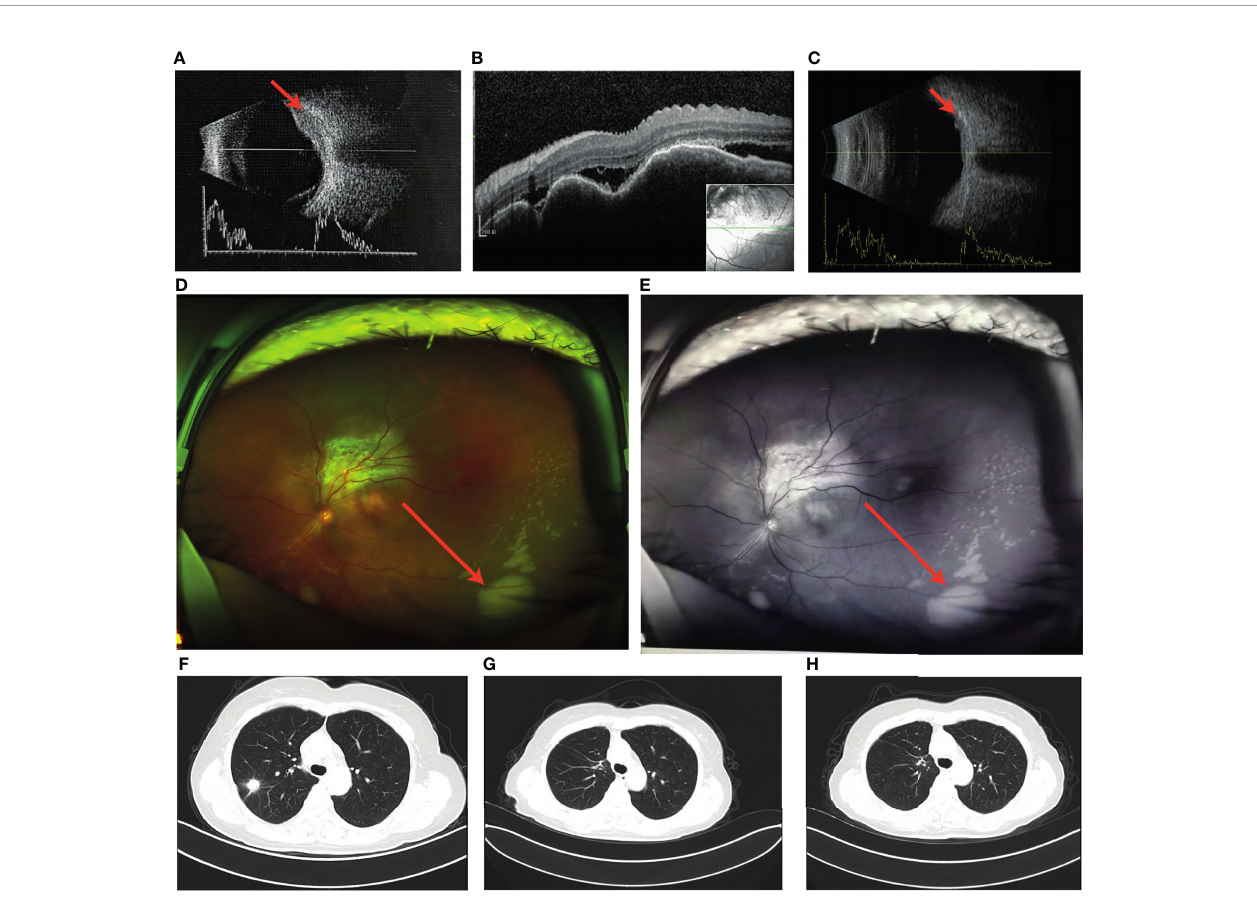
FIGURE 1 | (A) Ultrasound revealed the initial dome-like choroid lesion with the height 2.5 mm: (B) Optical coherence tomography (OCT) demonstrated a plateau- like elevation of choroid with underlying sub retinal fl uid; (C) The height of the lesion reduced to 0.75 mm 18 months after crizotinib therapy; (D,E) Left fundus image revealed a large dome-shaped amelanotic tumor; (F) A nodule in the right upper lung; (G) Regression of the primary lesion 2 month after surgery; (H) No progression of malignancy in the 18th month of crizotinib